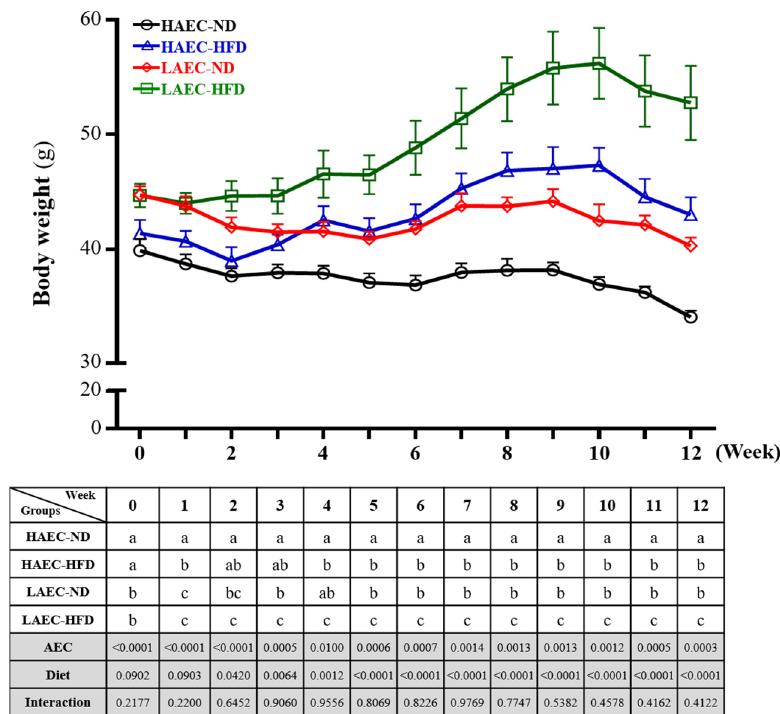
Figure 1. Effects of 12 weeks of high-fat diet (HFD) feeding of high aerobic exercise capacity (HAEC) or low aerobic exercise capacity (LAEC) postpartum mice on body weight. Data are mean ± standard error of the mean (SEM) for n = 8 mice per group. Columns with different superscript letters (a, b, c) in table are significantly different between the group at p < 0.05. Table 1. Baseline exercise capacity, growth curve and dietary profiles during experiments.